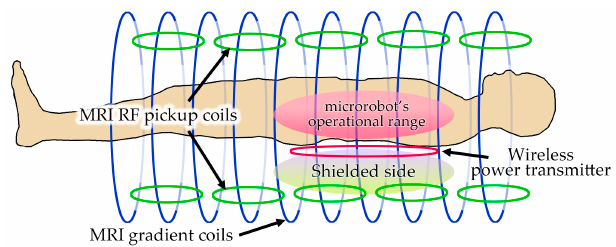
Figure 1. Schematic of the simultaneous usage of microrobot actuation and magnetic resonance imaging (MRI) coils to provide function and location feedback for implanted medical devices.